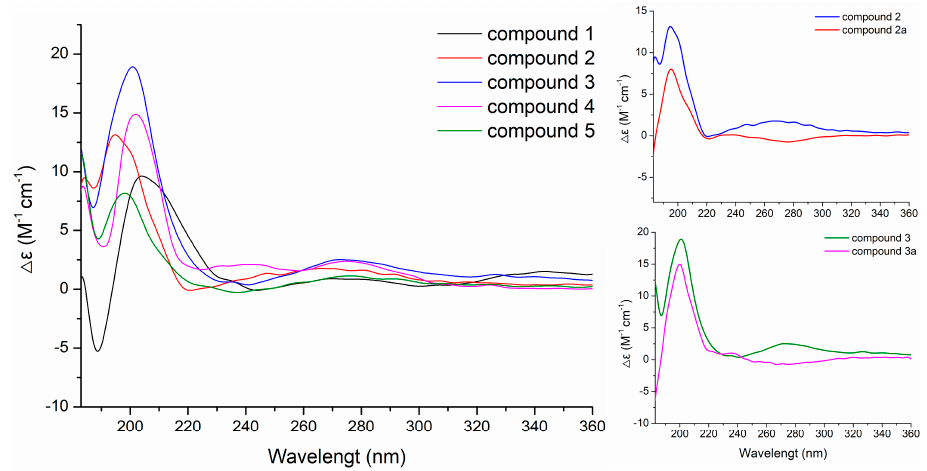
Figure 6. Experimental CD spectra of 1 – 5 in CH 3 CN